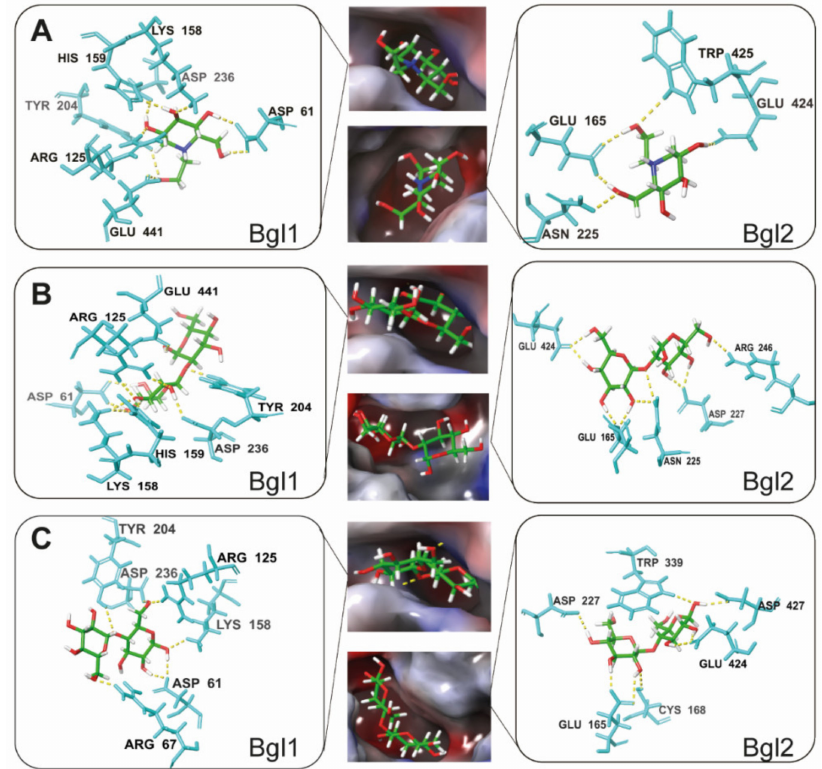
Figure 3. Binding modes of three substrates with Bgl1 and Bgl2. The interactions between miglitol ( A ); sophorose ( B ); and cellobiose ( C ) with the associated residues at the active site of β -glucosidase. 3D surface representation of the ligand-binding pocket (ligands displayed in stick mode) is in the middle of the figure. The black labels and yellow lines show the residue names and hydrogen bonds,